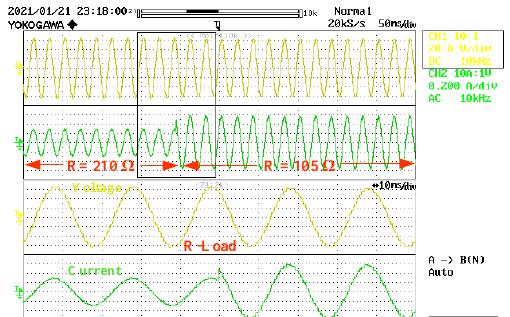
R = 210 Ω Voltage Current Figure 11. Load change from no-load to 210 Ω. Figure 12. Harmonic spectrum.